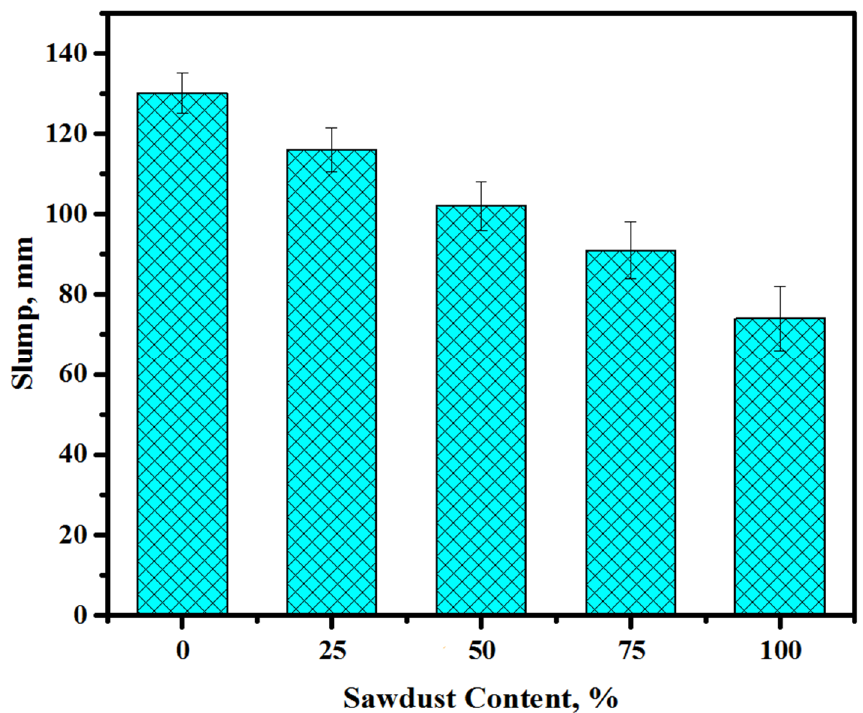
Figure 5. Slump values of the prepared alkali-activated concretes.